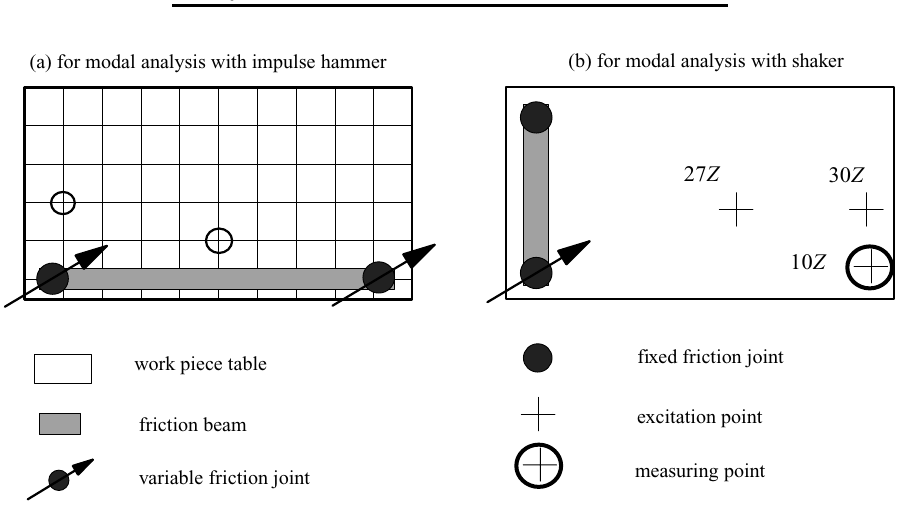
Fig. 7. Studied configurations of the friction